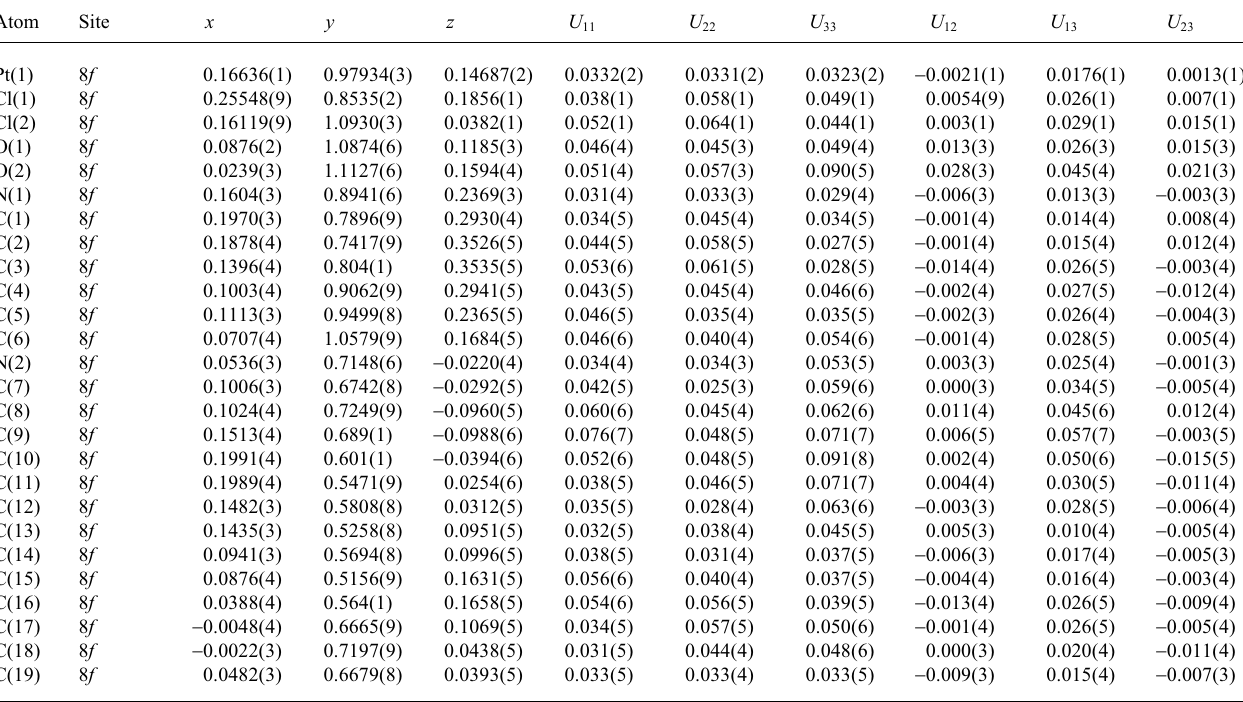
Table 3. Atomic coordinates and displacement parameters (in Å 2 )